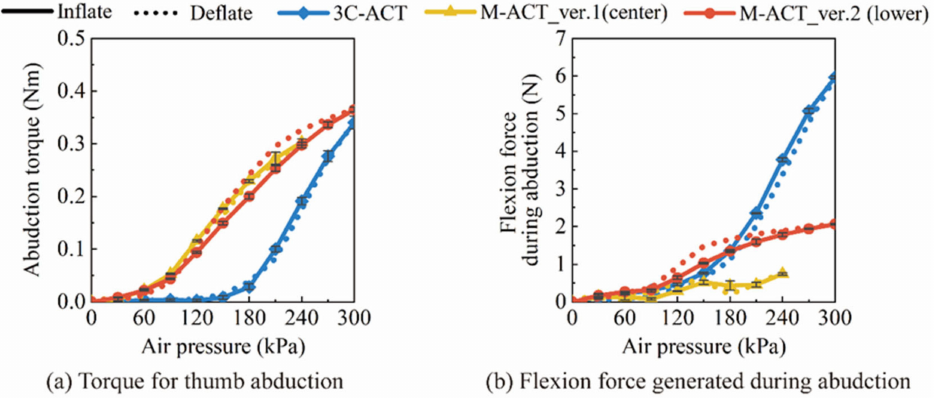
Figure 6. Abduction torque and flexion force output during left-side chamber/module air